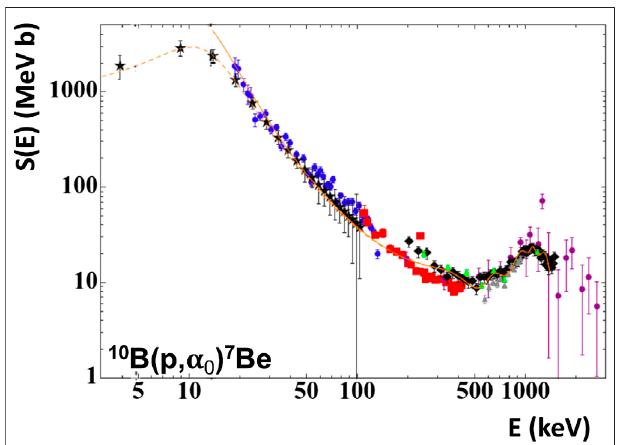
Spitaleri et al. (2014) (black stars) and direct data from Caciolli et al. (2016) (green triangles), Lombardo et al. (2016) (grey triangles), Roughton et al. (1979) (purple circles), Angulo et al. (1999) (blue circles) and Youn et al. (1991) (redsquares).ThedashedlinerepresenttheR-matrix fi